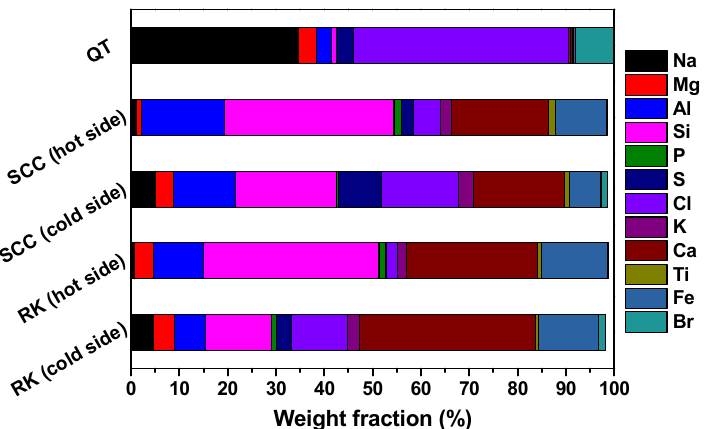
Figure 4. SEM micrographs and EDS analysis of the slagging samples collected from the wall of the quench tower.